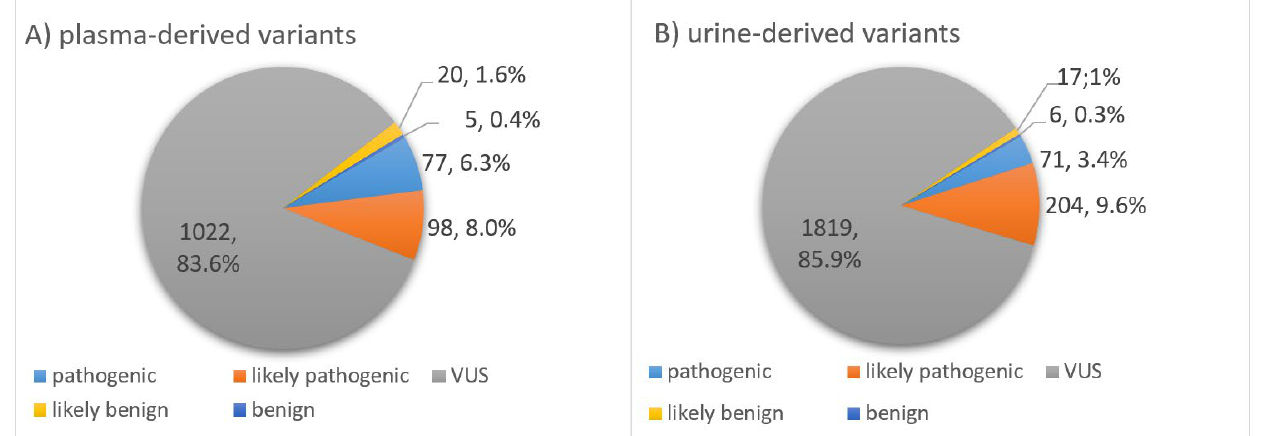
Figure 4. Impact. Classification of somatic variants found in ctDNA of ( A ) plasma and ( B ) matching urine samples of 15 TNBC patients after application of a personalized filter cascade. Using QCI Interpret Translational (QIAGEN), variants were classified into five subgroups according to their impact: pathogenic, likely pathogenic, variant of uncertain significance (VUS), likely benign or benign. Per plasma sample, median numbers of 5 pathogenic, 6 likely pathogenic, 53 VUS, 1 likely benign and 1 benign variant were found in the ctDNA. Having a look at the variants